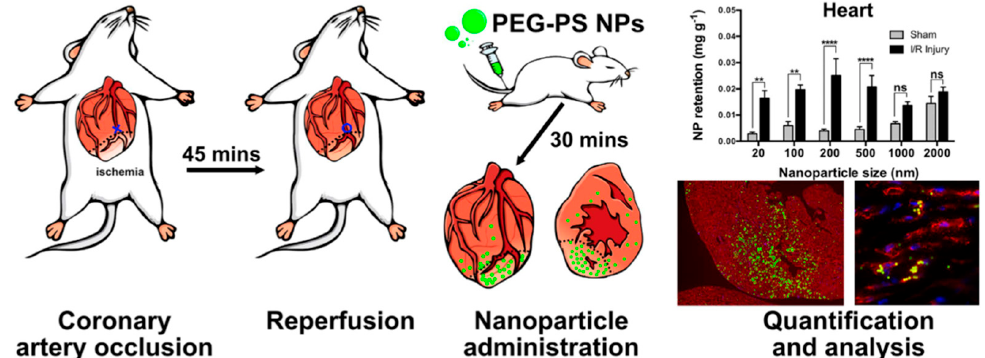
Figure 1. Passive EPR-based nanoparticle retention by the infarcted heart is low. The coronary artery was occluded for 45 min, then the blood flow was restored to create an ischemia-reperfusion injury. Thirty minutes after myocardial reperfusion, PEG-modified polystyrene nanoparticles bearing a green fluorescent dye were administered by the tail vein. Uptake was quantified by HPLC and fluorescence microscopy. The results showed that nanoparticle uptake by the infarcted heart was greater than sham but represented less than 1% of the injected nanoparticle dose. ns = not significant, ** = p ≤ 0.01, **** = p ≤ 0.0001. Figure reproduced from [46].